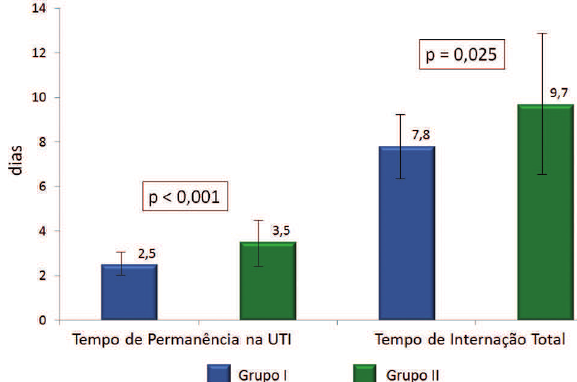
Fig. 1 - Comparação dos tempos médios, em dias, com desvio